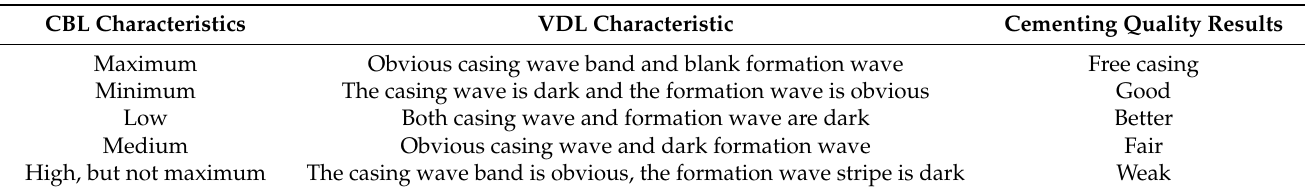
Table 1. Marking method of cementing quality training